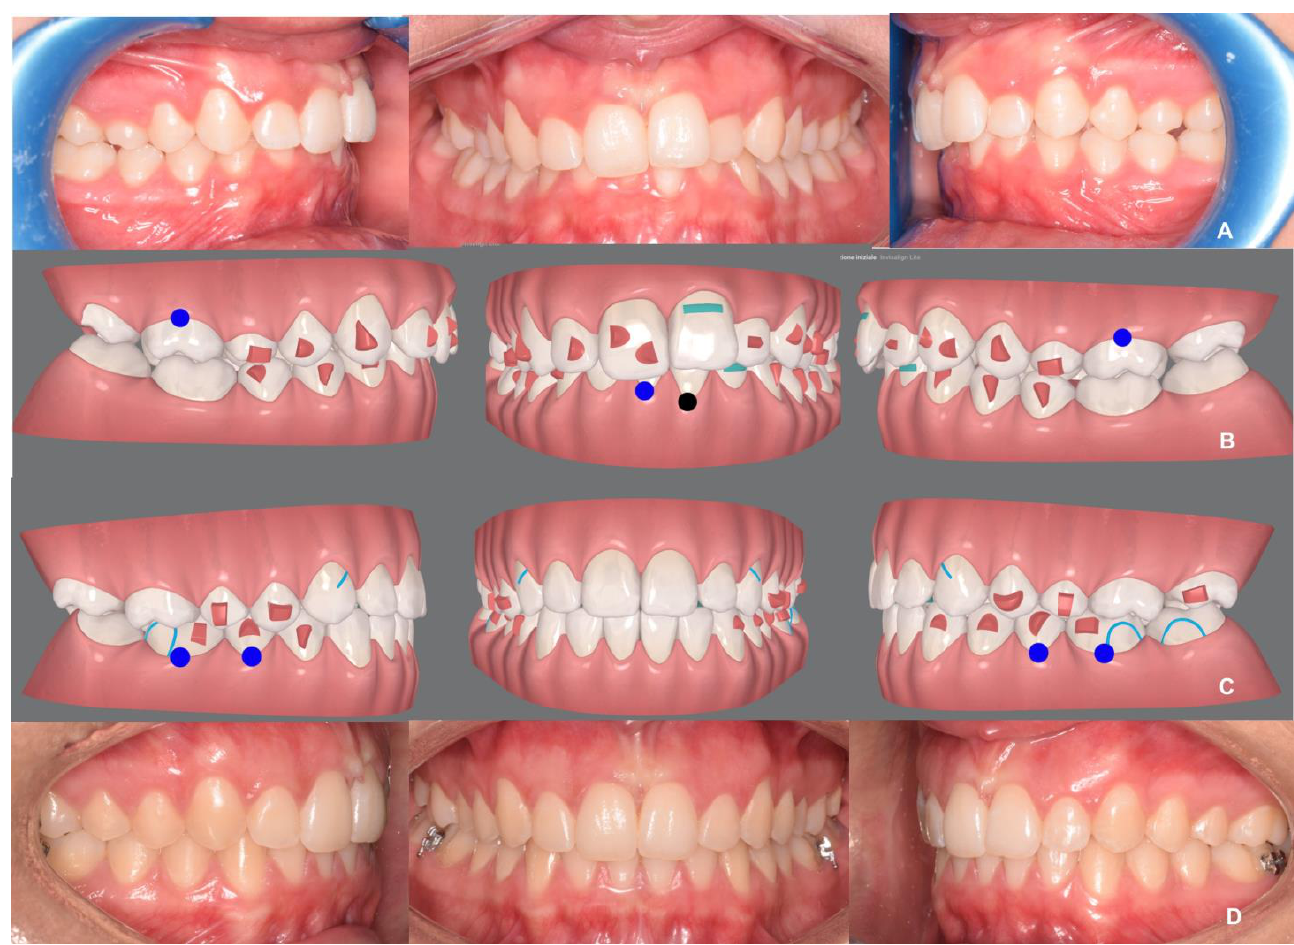
Figure 11. Orthodontic setup with programmed tooth movement and biomechanical principles using Invisalign system (Align Technology, San Jose, California, USA). ( A ), Pre-treatment occlusion; ( B ), pre-treatment digital reproduction of dental arches; ( C ), post-treatment digital project; ( D ), post-treatment occlusion (see the incomplete correction of the overbite compared to the digital project). Pink shapes over teeth’s surface are the digital representation of the attachments programmed to increase the predictability of dental movement and the aligners’ fitting. Dots at the gingival level represent the alert system indicating respectively low predictability (blue dot) and very low predictability (black dot) for the programmed movement. At certain steps, the usage of class II elastics was planned by requesting the introduction of specific “line cuts” into the aligner (( C ), blue lines) for inter-maxillary elastics fitting.